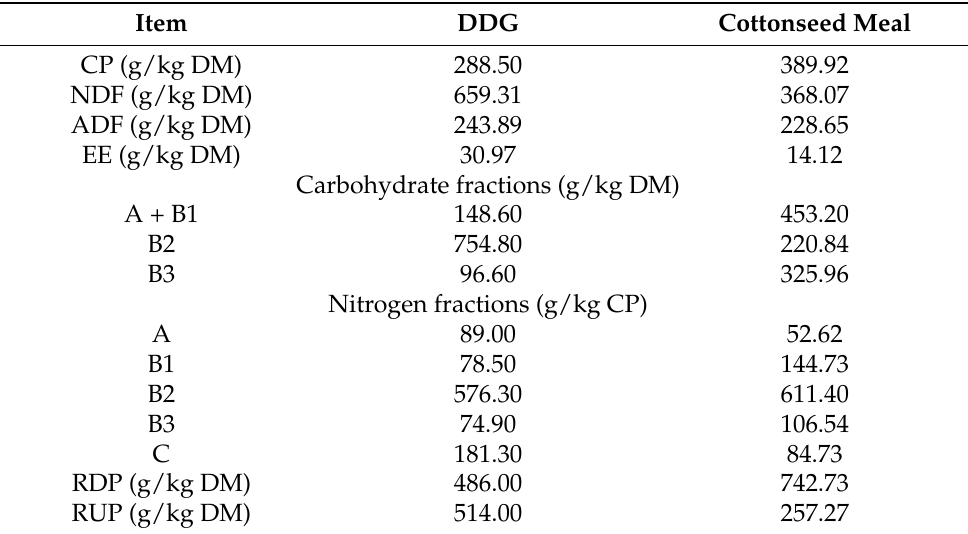
Table 2. Chemical components, carbohydrate and nitrogen fractionating of corn DDG and cotton- seed